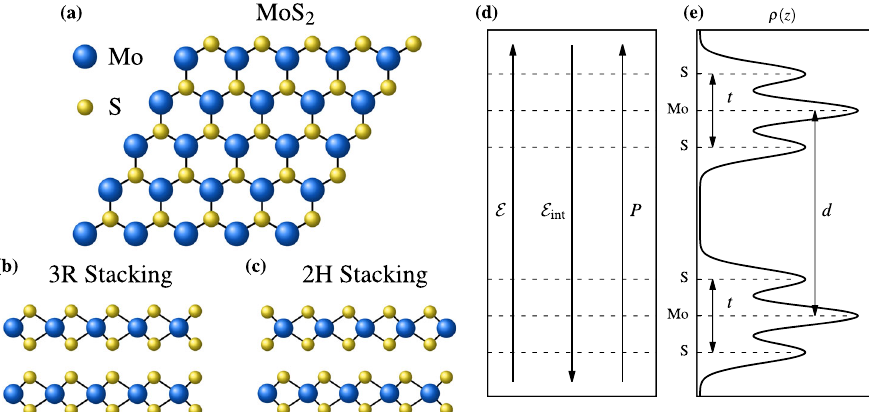
Fig. 1 Atomic and electrostatic sketches of bilayer Mos 2 . a Atomic structure of a MoS 2 monolayer. The two stacking con fi gurations are shown below: b Alignment of the layers (3R stacking) and c the two layers mirrored with respect to one another (2H stacking or a twist of 180 ∘ ). d Sketch of the electrostatics of bilayer MoS 2 . The dashed lines indicate the vertical positions of the atoms, and the vectors show the applied fi eld E and resulting polarization P and internal fi eld E int . e Sketch of the charge density of bilayer MoS 2 along the out-of-plane direction averaged in the in-plane